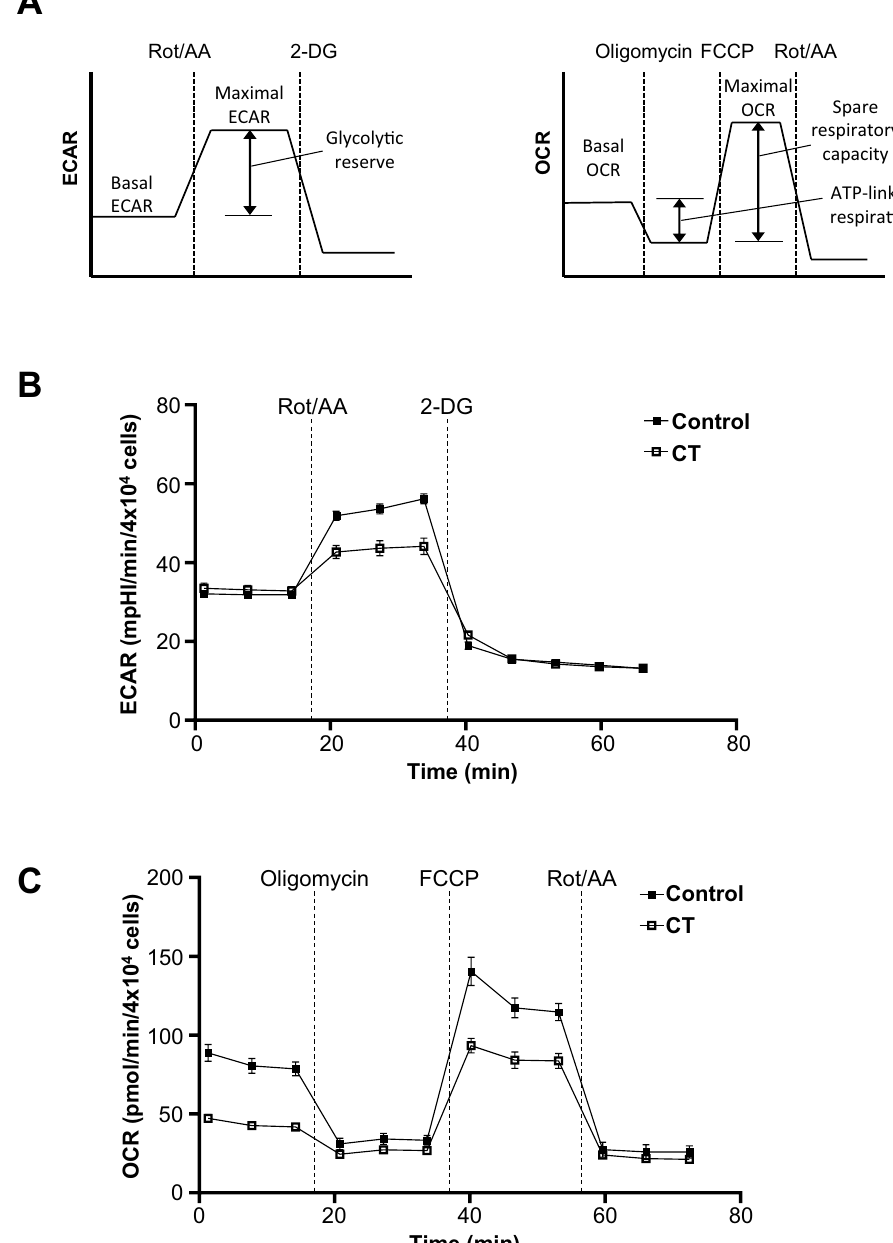
Figure 4. MDA-MB-231 maximal metabolic profiles with CT transfection. ( A ) Schematic indicating derivation of maximal metabolic rates, glycolytic reserve, and spare respiratory capacity from the experiment in ( B , C ). ( B ) ECAR assay for MDA-MB-231 transfected with CT. Cells were maintained in uniform media prior to measuring ECAR. ECAR was measured twice in the basal state, and then twice again following each metabolic inhibitor treatment (0.5 μM rotenone/0.5 μM antimycin A, 50 mM 2-DG) at 7 min intervals. ( C ) OCR assay for MDA-MB-231 transfected with CT. OCR was measured twice in the basal state, and then twice again